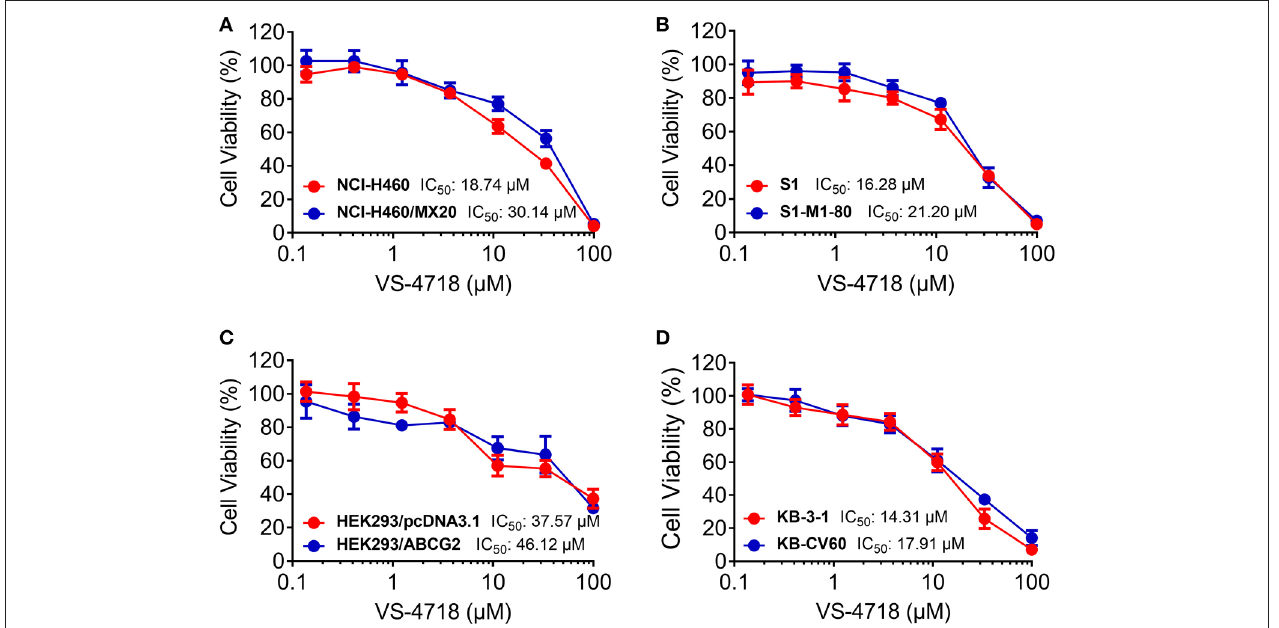
FIGURE 2 | Concentration-viability curves for parental and ABCG2- and ABCC1-overexpressing cells incubated with VS-4718. (A) Concentration-viability curves for NCI-H460 and NCI-H460/MX20 cells incubated with VS-4718 for 72h. (B) Concentration-viability curves for S1 and S1-M1-80 cells incubated with VS-4718 for 72h. (C) Concentration-viability curves for HEK293/pcDNA3.1 and HEK293/ABCG2 cells incubated with VS-4718 for 72h. (D) Concentration-viability curves for KB-3-1 and KB-CV60 cells incubated with VS-4718 for 72h. The cell viability was determined by MTT assay. Data are expressed as mean ± SD , representative of three independent experiments in